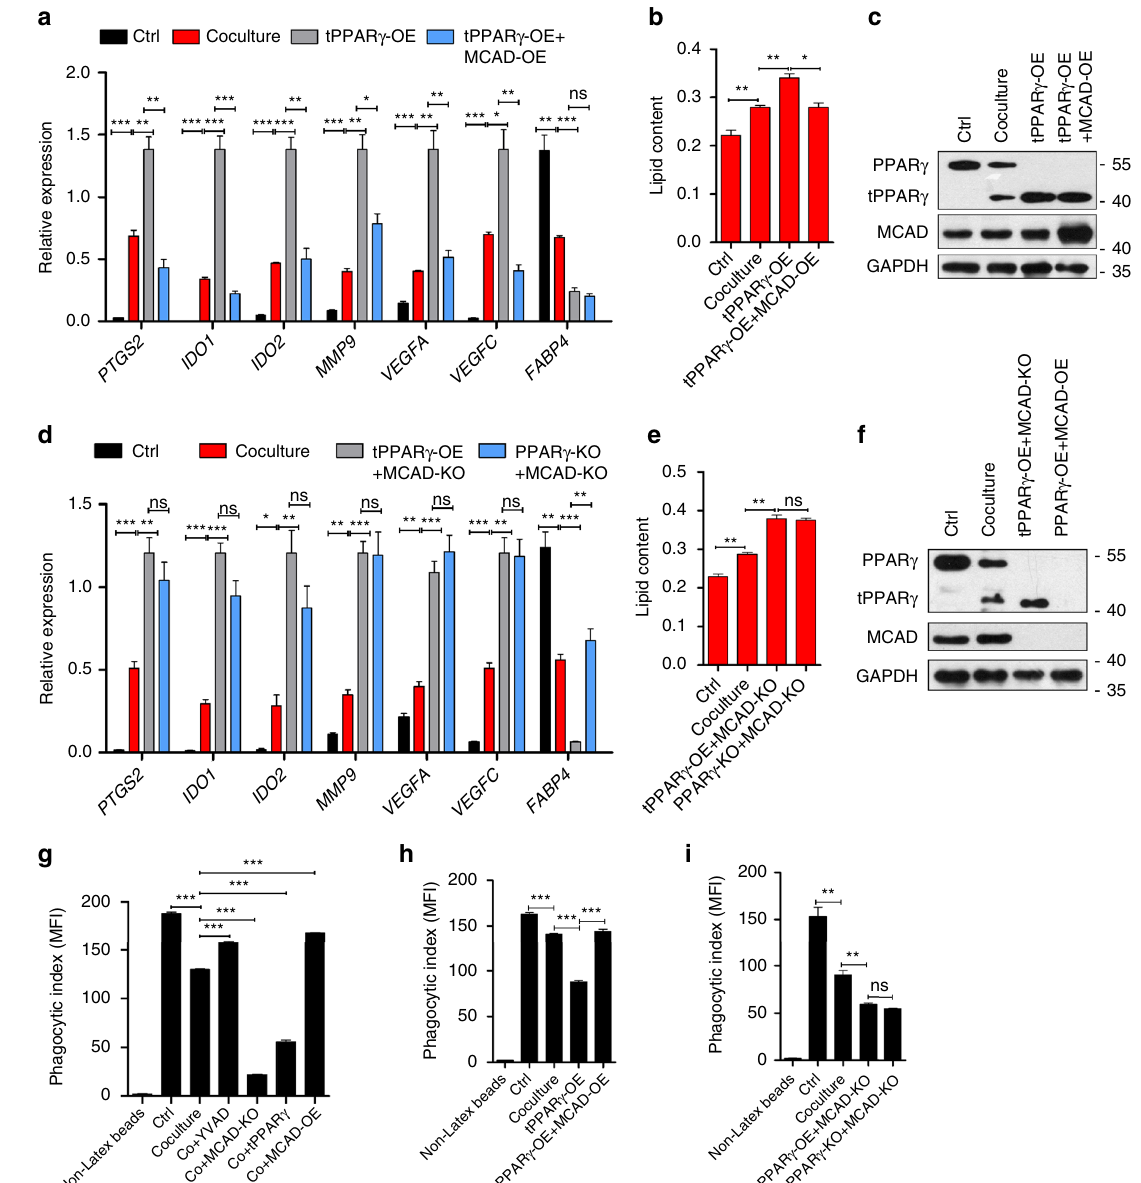
Fig. 8 tPPAR γΔ 64D regulates TAM differentiation and metabolic reprogramming through MCAD. a – c LacZ overexpressing THP-1 macrophages were cultured alone or cocultured with MCF-7 for 2 d, THP-1 macrophages overexpressing tPPAR γΔ 64D or simultaneously overexpressing tPPAR γΔ 64D and MCAD were cocultured with MCF-7 for 2 d, TAM hallmarks were analyzed by RT-qPCR ( a ) and lipid content was analyzed by Oil Red O staining ( b